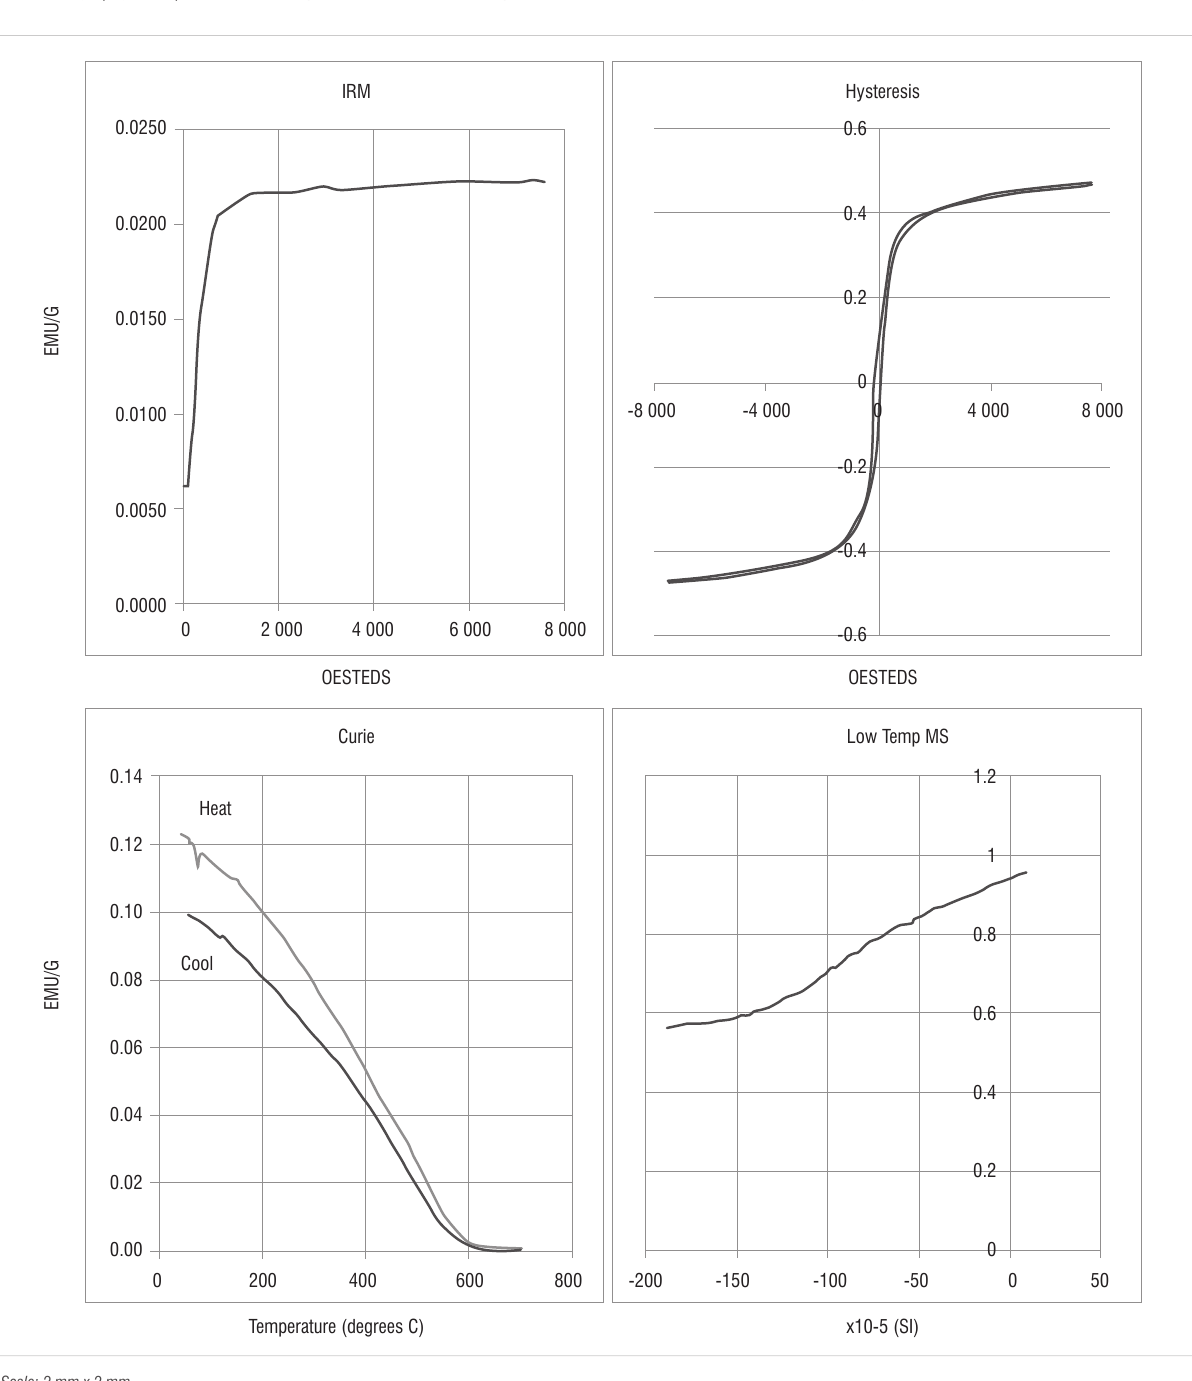
Figure 5: Mineral magnetic measurements – isothermal remanent magnetisation (IRM), hysteresis, thermomagnetic curve (Curie) and low temperature magnetic susceptibility (MS) – of a siltstone sample from